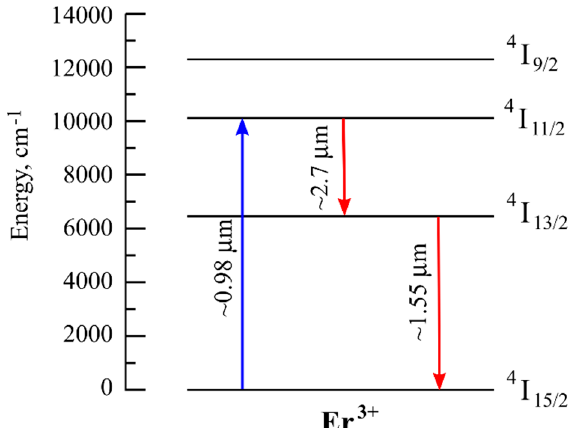
Figure 4. Simplified energy level diagram for Er-doped tellurite glass.